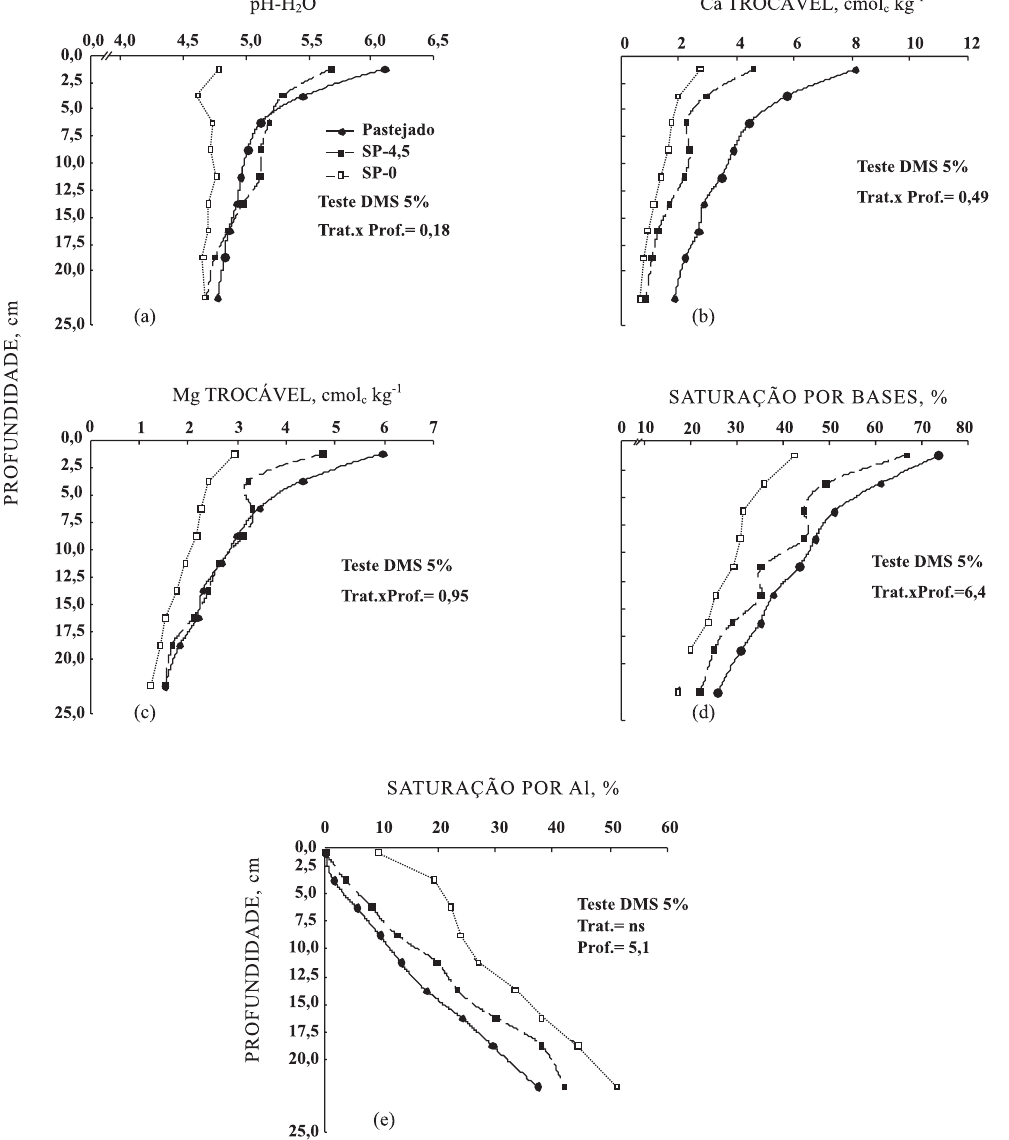
Figura 6. pH do solo (a) cálcio trocável (b) e magnésio trocável (c), saturação por bases (d) e saturação por alumínio (e) 24 meses após a aplicação de calcário em Latossolo Vermelho, sob sistema plantio direto e integração lavoura-pecuária, com diferentes pressões de pastejo no inverno (ns: não